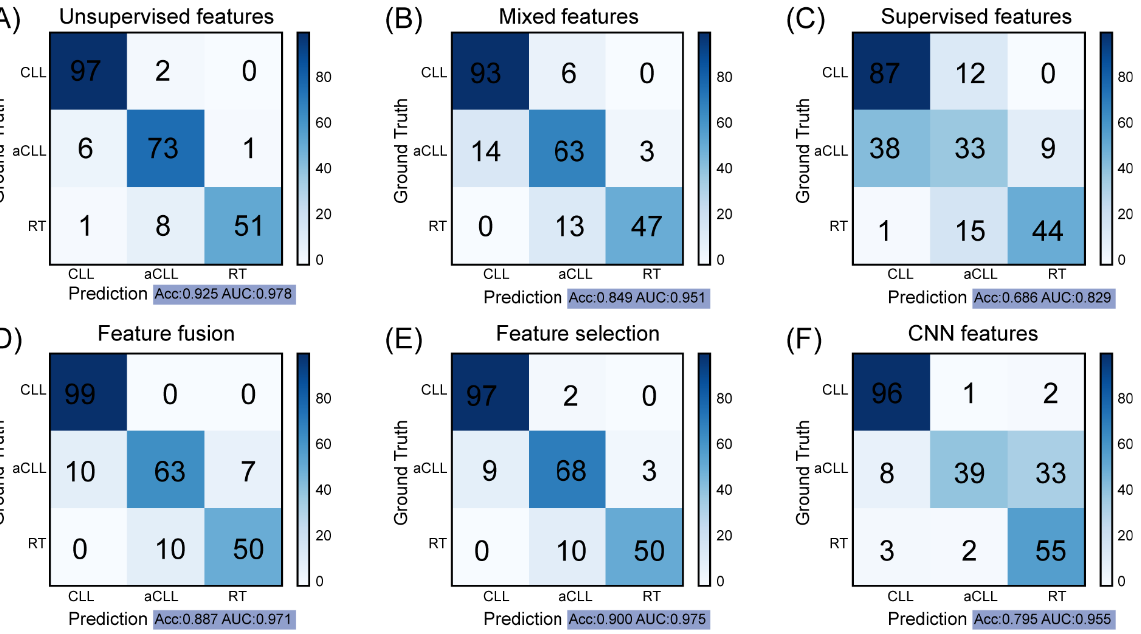
Figure 5. Performance of the proposed unsupervised cellular feature extraction and the five compared methods: ( A ) The proposed supervised features obtain the best performance among all compared methods. ( B , C ) presents the diagnostical outcome with the mixed and supervised features, respectively. ( D , E ) shows the results based on the feature fusion and feature selection. The feature selection exhibits superior performance compared with mixed, supervised, and fused features. ( F ) presents the performance with the CNN extracted ROI features, which exhibits inferior performance compared with cellular-based feature extraction methods.